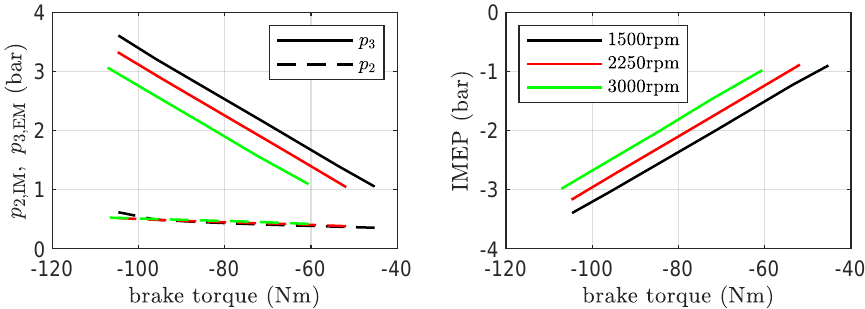
Figure 13. Engine braking with the Comprex. The different colours represent the different engine speeds. In the left subplot, the solid lines show the exhaust gas pressure p 3,EM and the dashed lines show the intake manifold pressure p 2,IM .